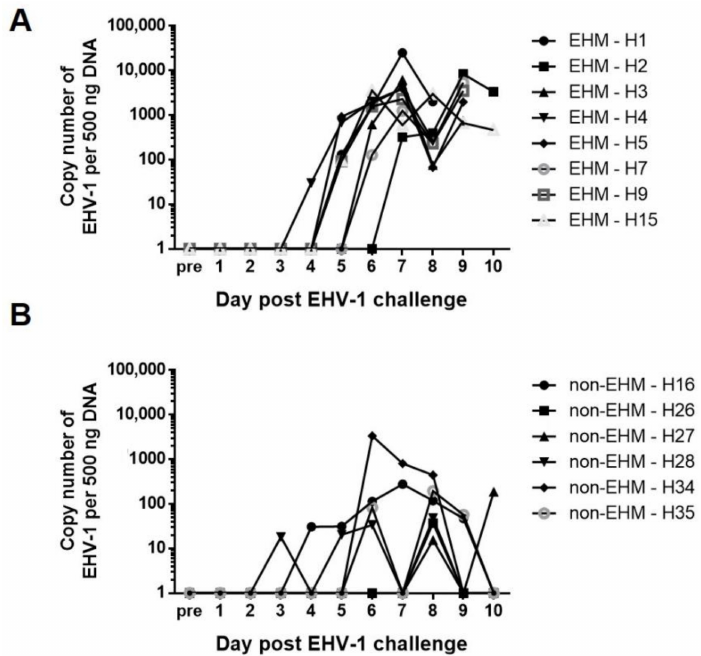
Figure 3. Viremia in ( A ) EHM and ( B ) non-EHM horses. Data is expressed as EHV-1 copy number per 500 ng template DNA as determined by qPCR. This data was obtained in conjunction with another study [54]. Day of peak viremia was determined for each horse and PBMCs from that day were used for each horse’s post-EHV-1 CH